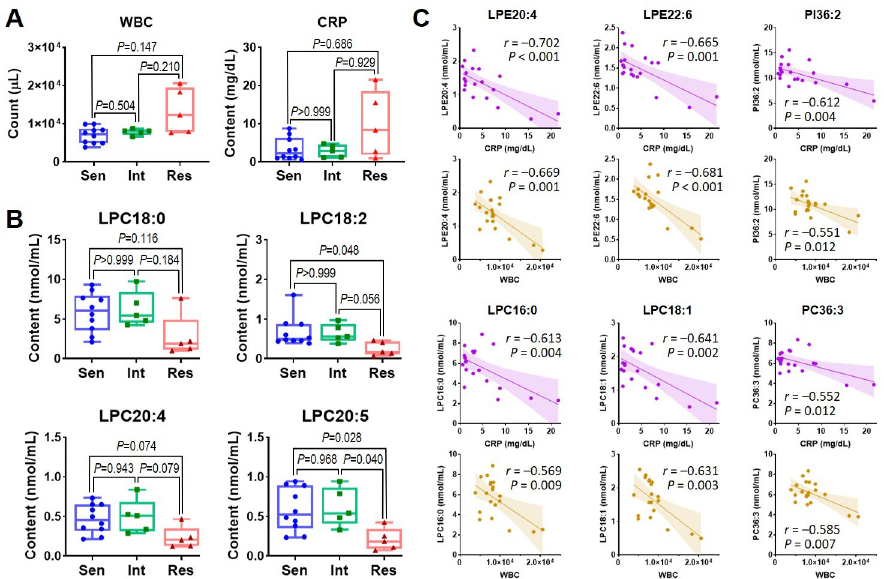
Fig 6. (A) Comparison of WBC and CRP among IVIG-sensitive, IVIG-intermediate, and IVIG-resistant groups after treatment. (B) Comparison of the most variant lipid species among IVIG-sensitive, IVIG-intermediate, and IVIG- resistant groups after treatment. (C) Correlation between the top relevant lipid species (LPE20:4, LPE22:6, PI36:2, LPC16:0, LPC18:1, PC36:3) and clinical features (WBC and